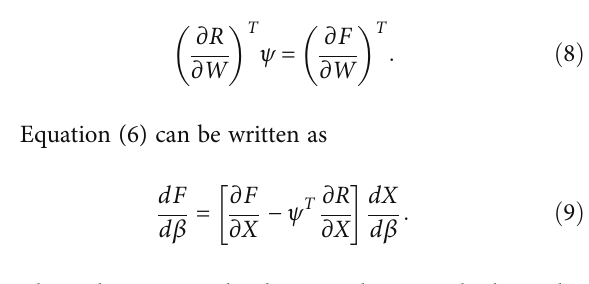
Figure 9: Surface pressure contour of SWB at di ff erent angle of attack at take-o ff